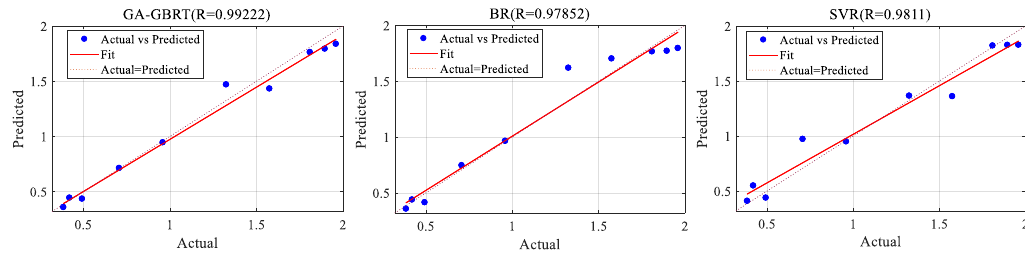
Figure 12. Regression curve between predicted surface roughness and actual surface roughness.